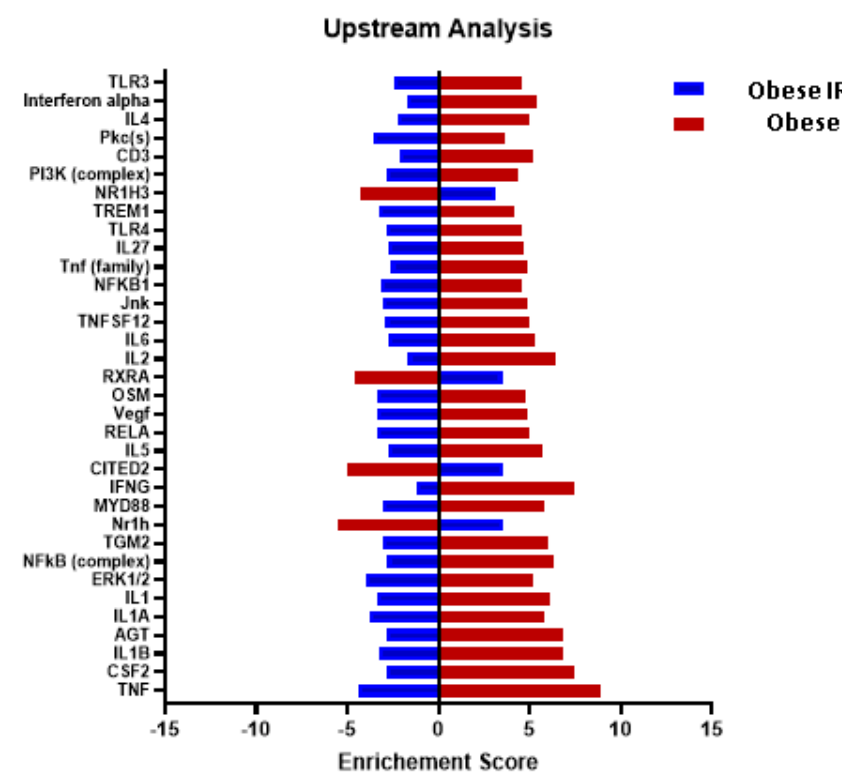
Figure 5. Upstream regulator analysis of differentially expressed genes in obese patients with IR-NGT and obese patients with T2D. Y-axis indicates the upstream regulator, and the x-axis represents the activation Z score. Red bars represent obese individuals with T2D, and blue bars represent obese individuals with IR-NGT.